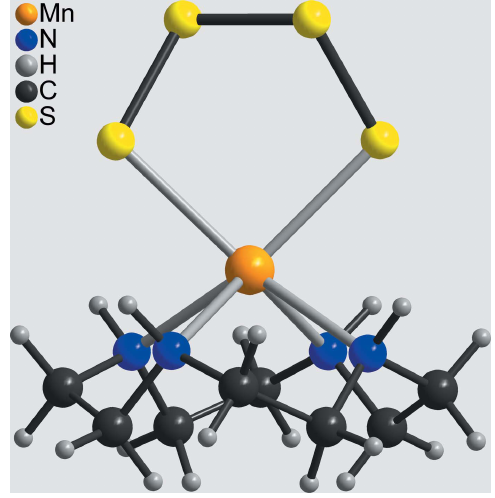
Figure 3 View of the Mn coordination sphere in the molecular structure of the title compound.